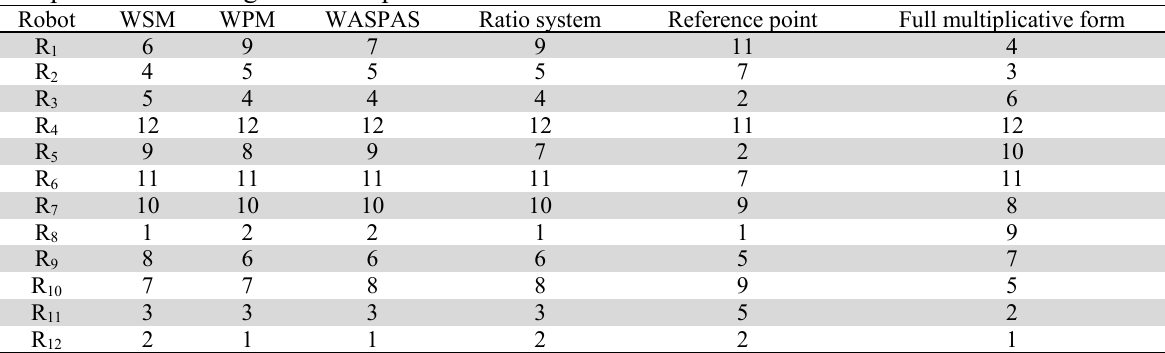
Comparison of rankings for Example